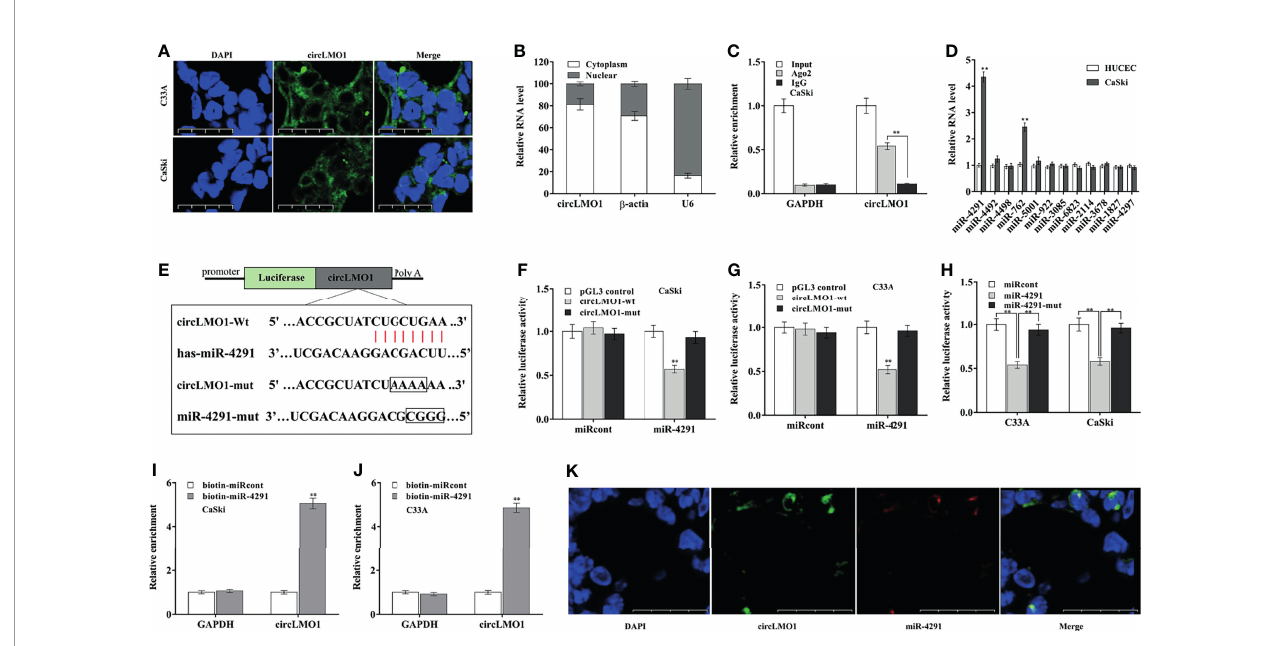
FIGURE 5 | CircLMO1 acts as a sponge for miR-4291 in cervical cancer cells. (A) FISH assay were carried out to assess circLMO1 cell localization in C33A and CaSki cells. The RNA probe targeting circLMO1 was stained green and the nucleus was stained blue. (B) qPCR analysis of circLMO1 levels in the cytoplasm and nucleus of C33A cells. U6 was used as a positive control in the nucleus, and b -actin was used as a positive control in the cytoplasm. (C) AGO2 antibody was used to perform RIP assay to determine the combination of circLMO1 and AGO2 in CaSki cells. (D) qPCR analysis was performed to assess miRNAs expression in CaSki and HUCEC cells. (E) Schematic diagram of the predicted miR-4291-circLMO1 interaction. (F – H) After co-transfection with miR-4291 (or its mutant) and circLMO1- wt luciferase reporter gene (or its mutant), luciferase activity was assessed in CaSki and C33A cells. After transfection with biotin-labelled miR-4291, qPCR analysis was performed to assess circLMO1 level in the streptavidin precipitation complex from CaSki cells (I) or C33A cells (J) . (K) The co-localization of circLMO1 and miR- 4291 analysed through double FISH assay in C33A cells. *p < 0.05, **p <